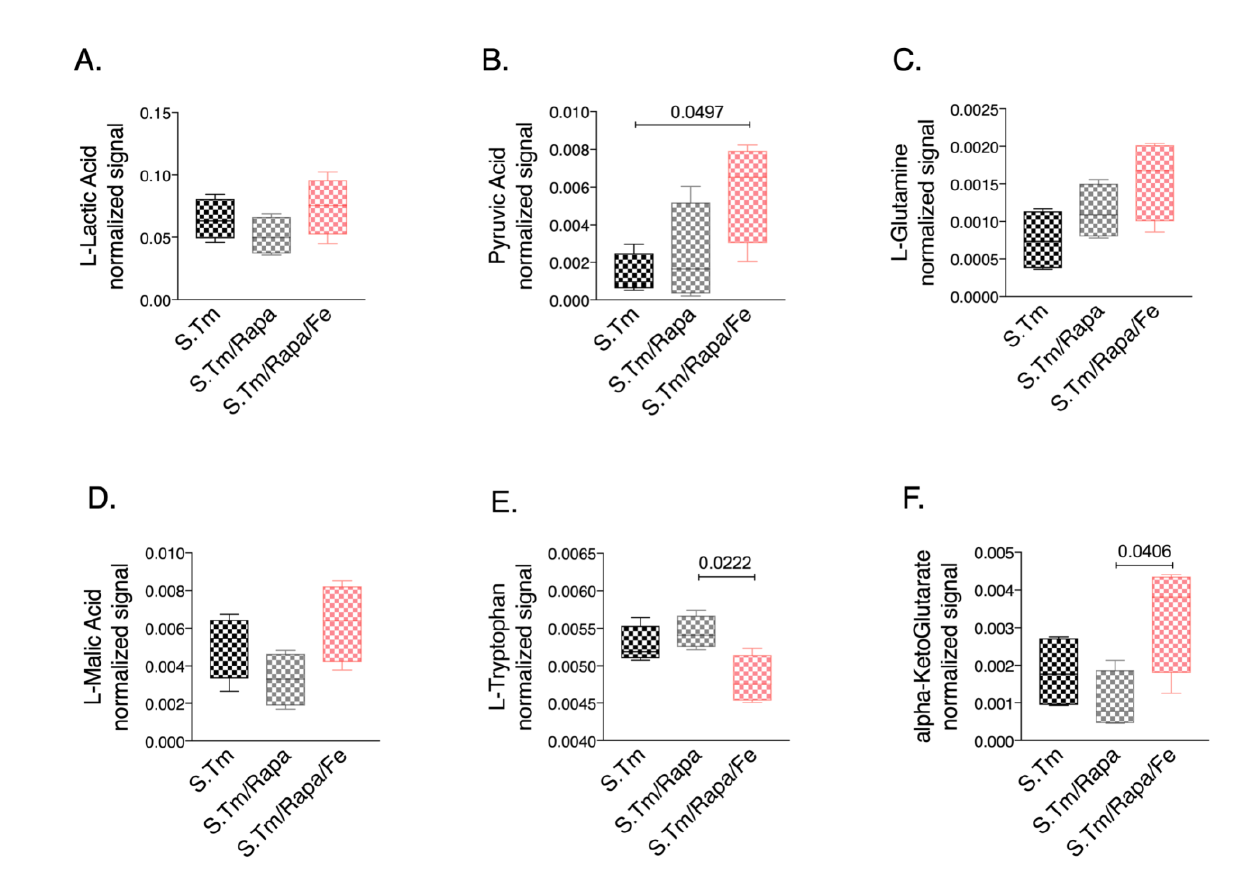
FIGURE 7: Metabolic effect of Salmonella infection, iron perturbation and mTOR inhibition in RAW264.7 cells . Selected metabolites anno- tated after the metabolomics analysis of cell supernatant of cells infected with Salmonella and treated with rapamycin or rapamycin and iron/hepcidin (Fe) for 24 hours. Data are shown as box plots. Statistical analysis was performed using One- way ANOVA with Tukey’s correc- tion. Exact p-values are indicated in the